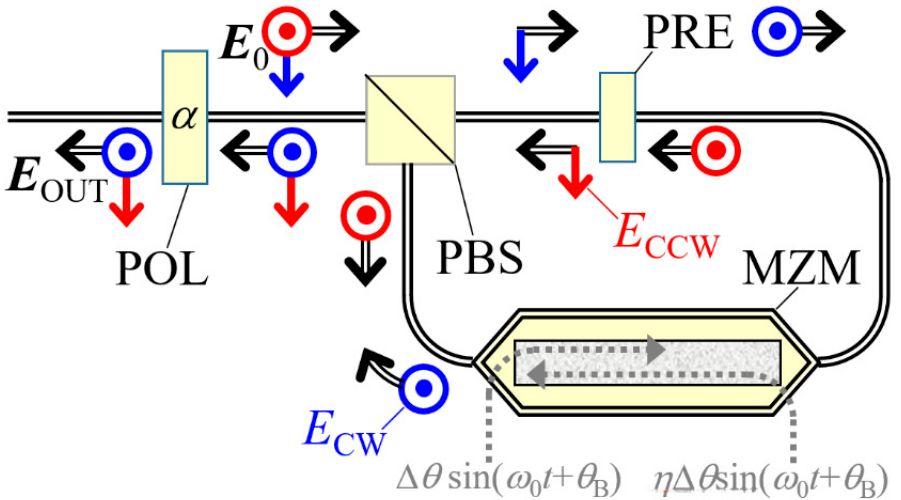
Figure 1. Analysis model of wavelength-tunable optical two-tone signals generation based on an MZM in PMSI with PRE. PBS: polarizing beam splitter, PRE: polarization-rotation element, POL: polarizer. Blue solid arrows and red solid arrows depict the electric field (polarization) of lightwave propagating in the PMSI in the clockwise direction and the counter-clockwise direction, respectively. In the configuration, lightwaves propagate according to black open arrows. Dashed arrows indicate the RF signal modulating lightwave in the